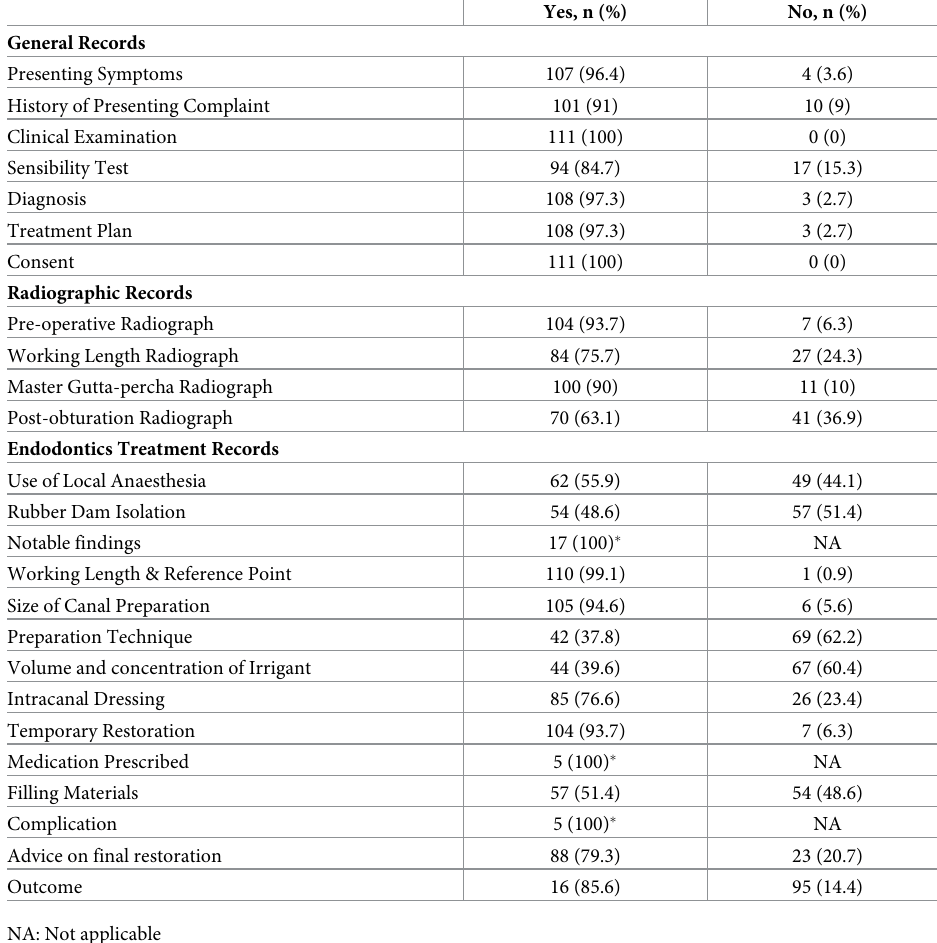
Table 2. Documentation of patient general, radiographic, and endodontic treatment